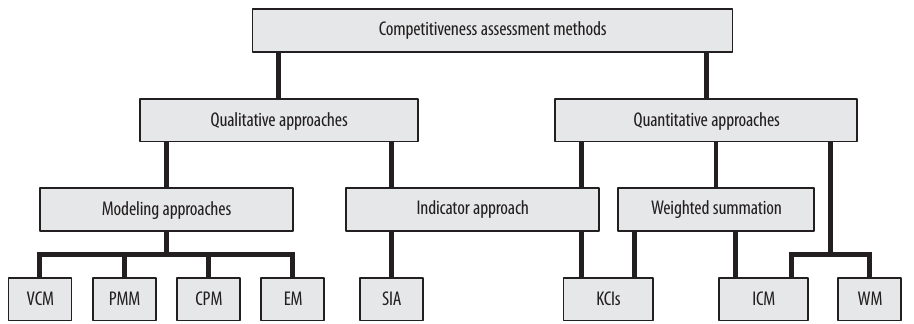
Figure 2. The composition of typical assessment methods for organizational